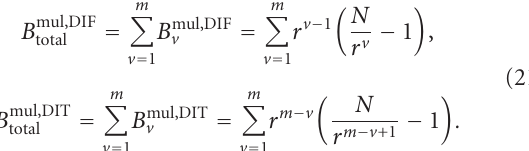
Figure 10: Block diagram of the identical IDFTs between interme- diate stage v and the IFFT